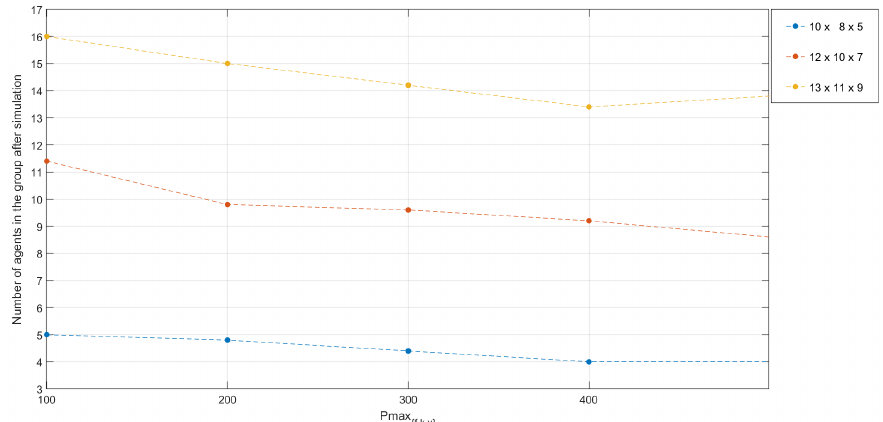
Figure 10. Removing agents from the group with dependence on TRr { f , k , v } ; the simulation lasted for 30,000 iterations; 50 agents were added into the group in the 1000th iteration: Pmax { f , k , v } = 400, TCr { f , k , v } = 8 and Penr { j , m , i } = 5 ∗ Pmax { f , k , v } .